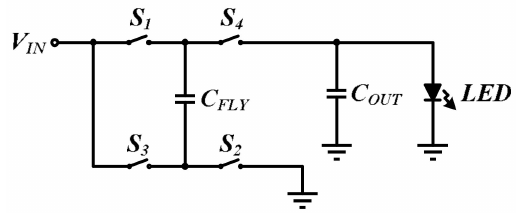
Figure 2. Schematic of a light-emitting diode (LED) driver with charge